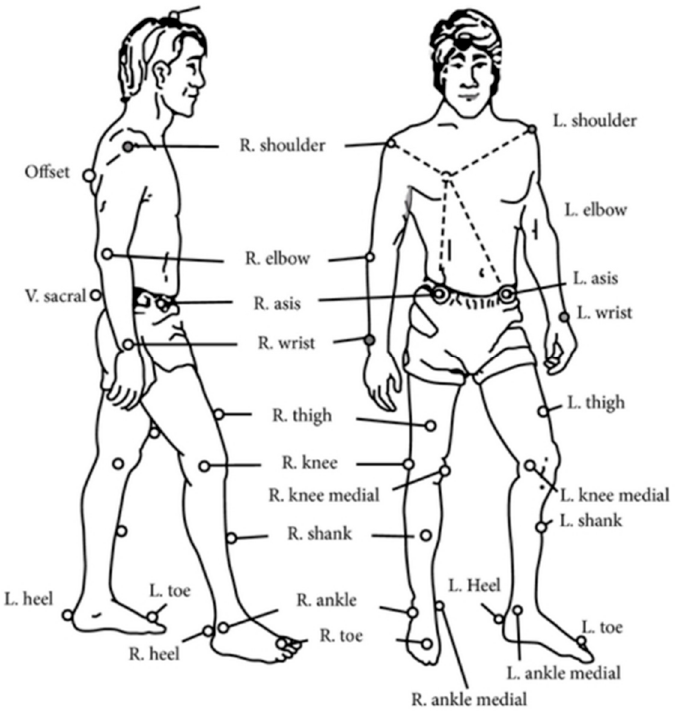
Figure 4. Modified Helen Hayes marker arrangement utilized for 3D motion analysis.